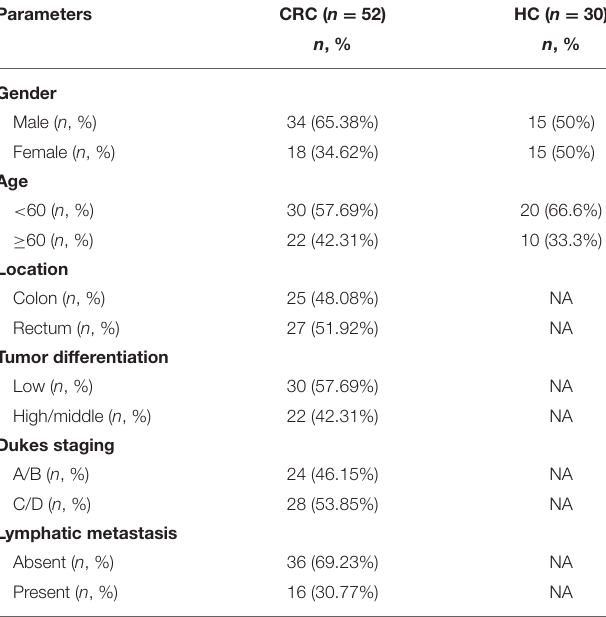
TABLE 1 | The characteristics of enrolled